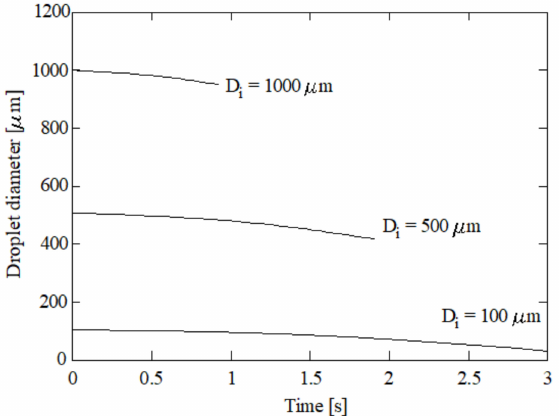
Figure 6. Droplet diameter against time for several initial diameters. 5% initial ammonia concentra- tion, 100 ◦ C initial gas temperature, and 5 ◦ C initial liquid temperature.